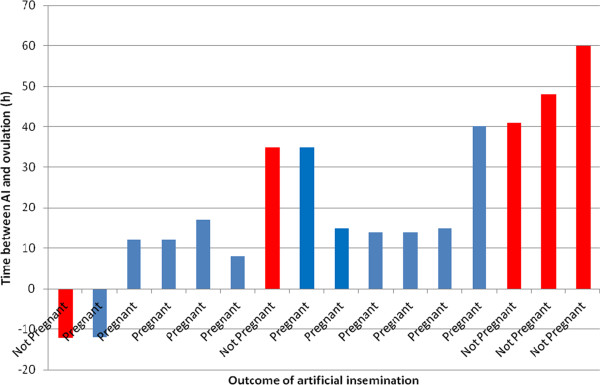
Time between artificial insemination and ovulation and the outcome of the artificial insemination (n = 16). Note: the data are sorted according to age of spermatozoa, as in Figure 1.